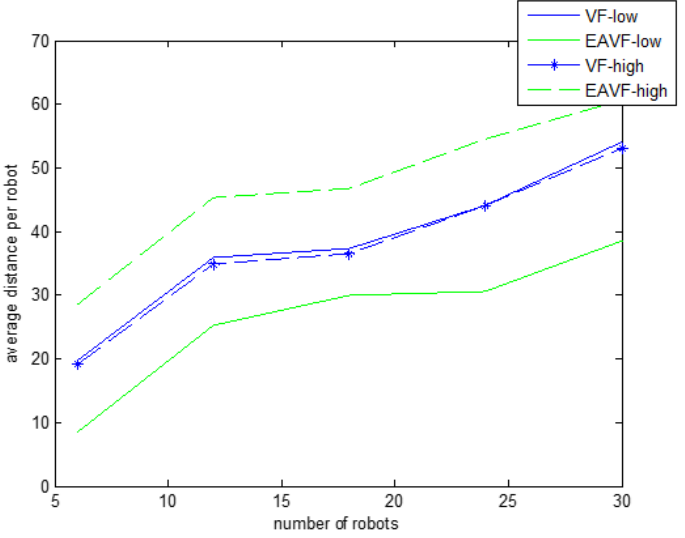
Figure 11. The average distance traveled per robot in the original virtual force and the energy aware approach.